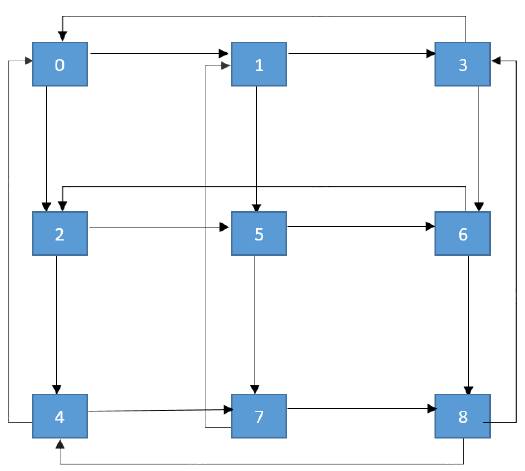
Figure 4. The state transition diagram of two-unit parallel system with three